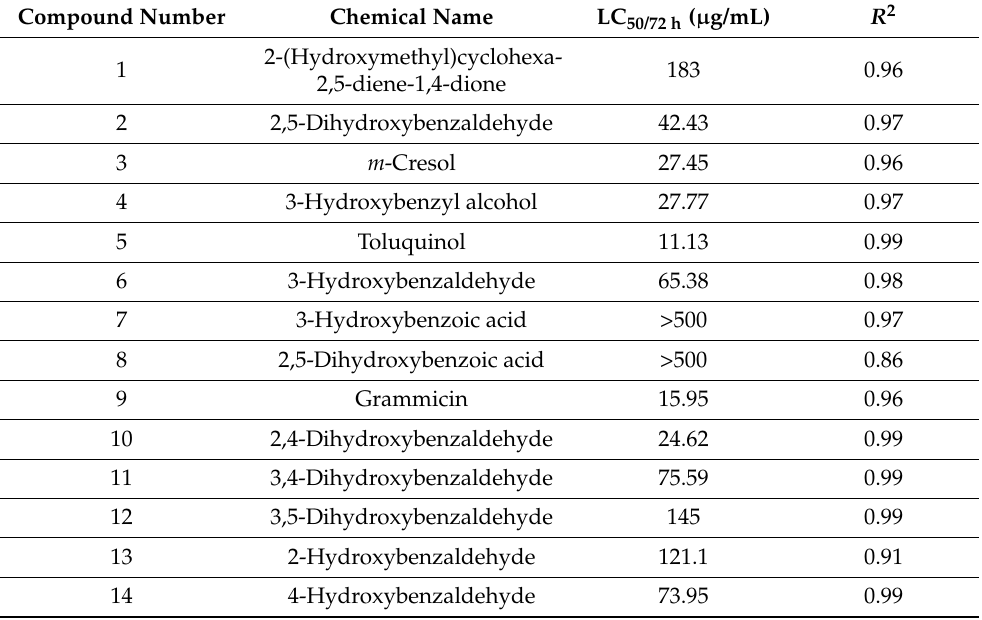
Table 1. LC 50 values for Meloidogyne incognita second-stage juvenile mortality subjected to various compounds, including two purified metabolites produced by the grammicin-knockout mutant strain (TR74) of Xylaria grammica . Compound